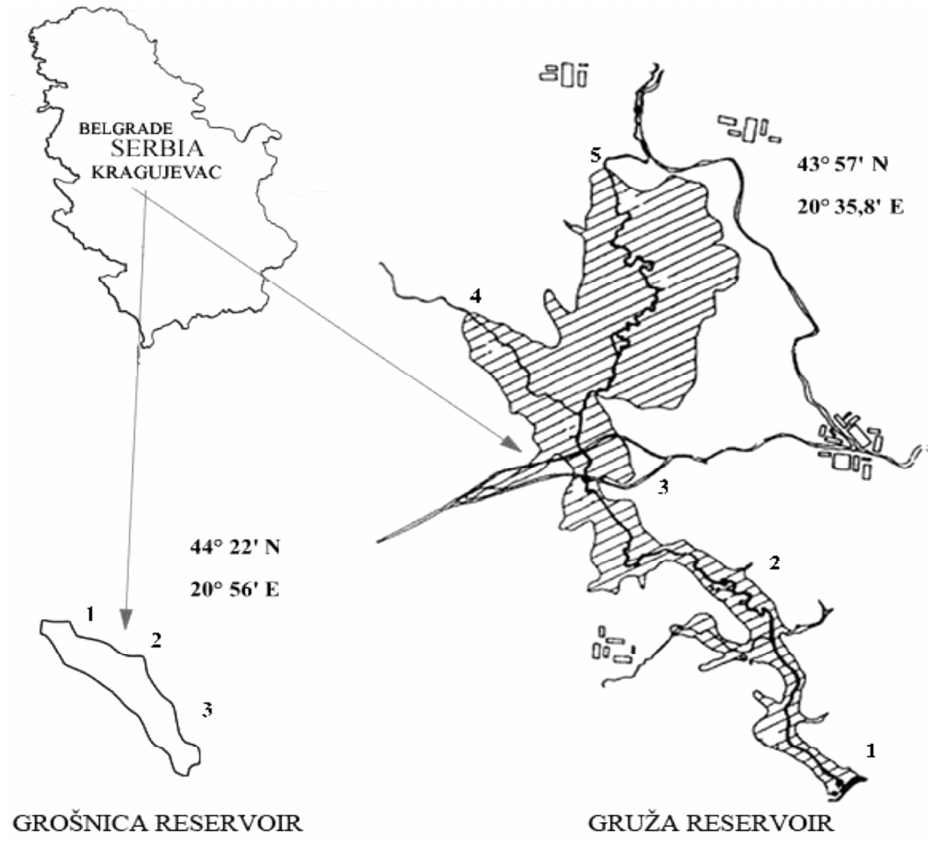
Figure 1. The Gruža Reservoir and the Grošnica Reservoir with sampling points (1 – Dam, 2 – Center, 3 – Bridge, 4 – The mouth of the Bora č River, 5 – The mouth of the Gruža